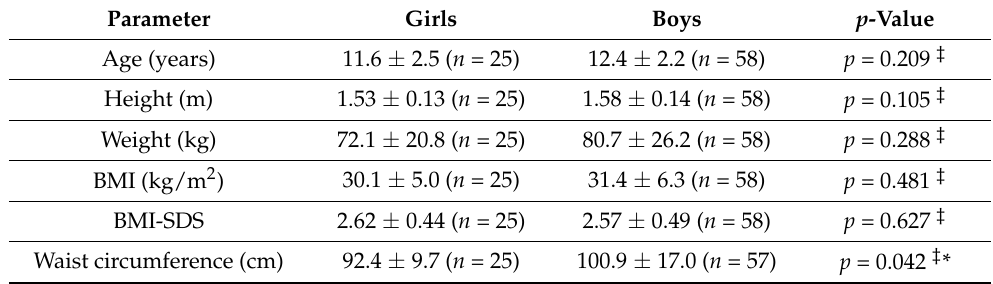
Table A2. Anthropometric data for the group of sarcopenia present in girls and boys.